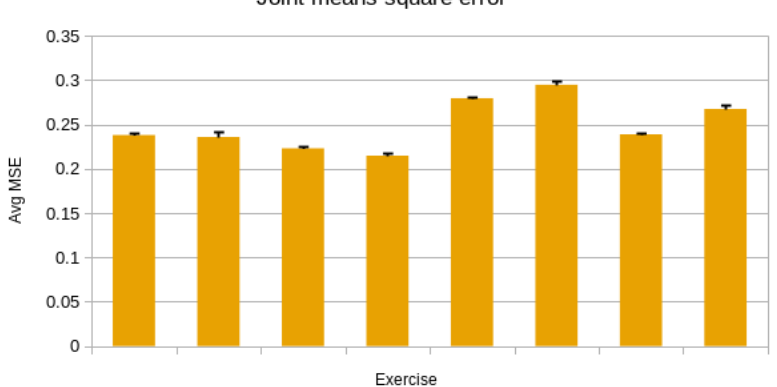
Figure 9. Skeleton inverse kinematics joint MSE by